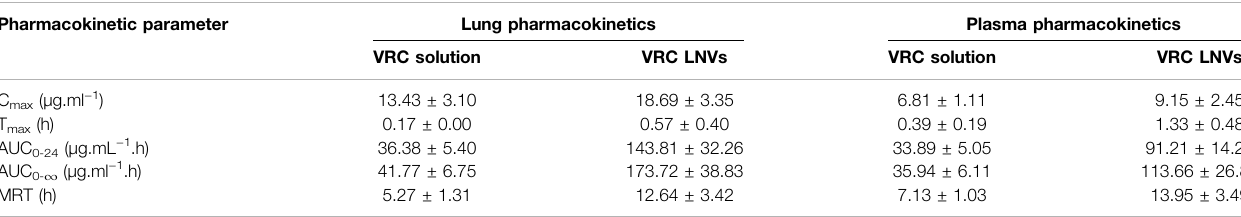
TABLE 4 | Pharmacokinetic parameters (Mean ± SD, n (cid:2) 3) of voriconazole (VRC) and lipid nanovesicles following 20 min of nebulization. Pharmacokinetic